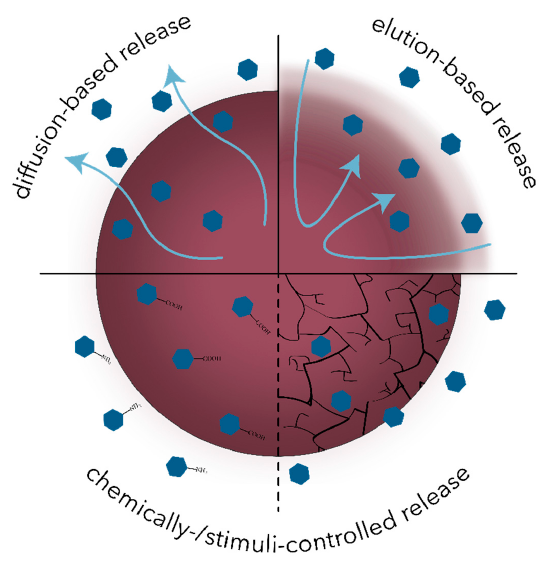
Figure 4. Schematic representation of the main mechanisms involved in the controlled release of antimicrobial drugs.